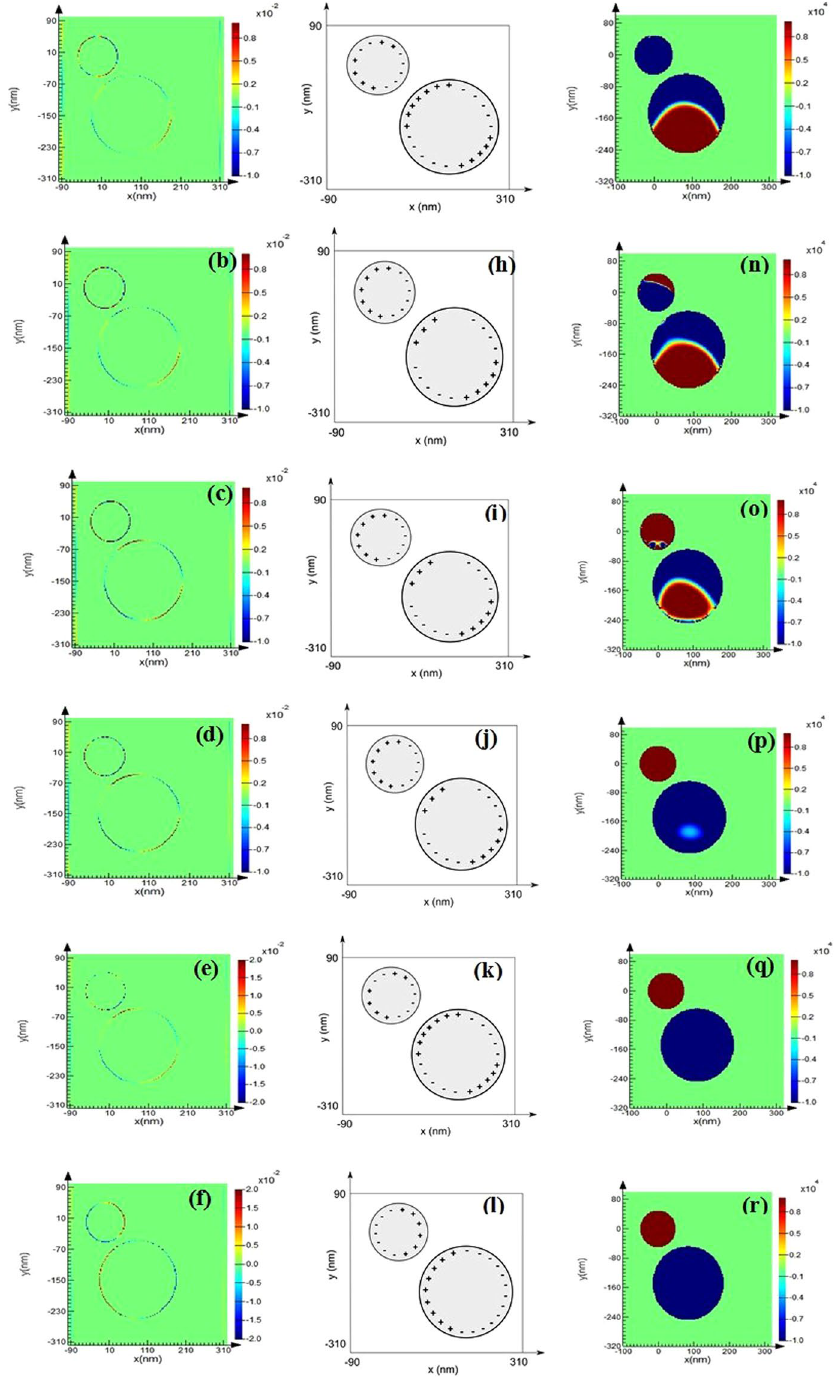
Figure 6. For off axis Ag-Au and by rotating the big particle [the configuration of Fig. 1(d) and ‘ ȹ ’ = 70 degree]: Considering parallel polarized light, from left first two columns represent surface charges [( a – l )] and the third column represents steady state current [( m – r )]. We have chosen six wavelengths for six different rows (from top to bottom): 338, 354, 400, 457, 485 and 612 nm. Charge distributions: ( a ) QQ ( b ) DQ ( c ) DQ ( d ) DQ ( e ) QQ ( f ) DD; where Q and D mean quadrupole and dipole